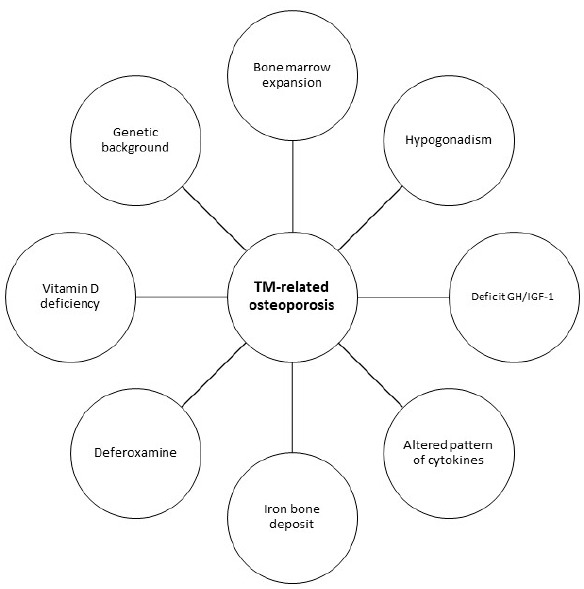
Figure 2. Pathogenetic factors of TM-related osteoporosis. TM: Thalassemia Major.